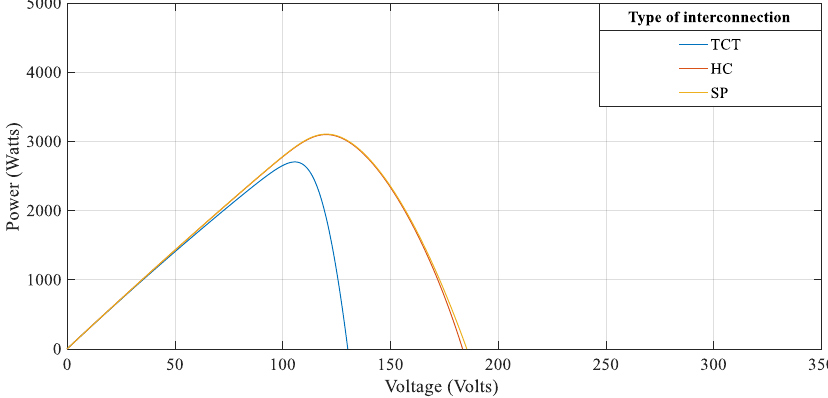
Figure 9. P-V curve for short circuit fault ‘F2′ (monocrystalline PV).